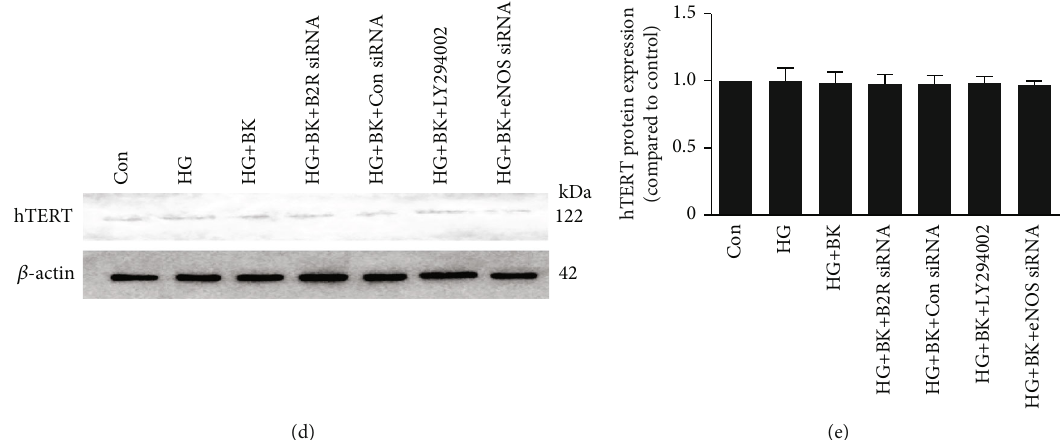
Figure 5: E ff ects of BK on mtDNA copy number, the relative length of telomeres, and hTERT translocation and hTERT expression in EPCs treated with HG. (a) The relative mtDNA content in EPCs was detected by real-time PCR. (b) The relative length of telomeres in EPCs was detected by real-time PCR. (c) Representative immunostaining is shown for the distribution of hTERT. Mitochondria, red fl uorescence; hTERT, and green fl uorescence. (d, e) Western blotting for hTERT in EPCs. Bars represent the means ± SD ( ∗ P < 0 : 05 versus control; # P < 0 : 05 versus HG; & P < 0 : 05 versus HG + BK ; n = 6